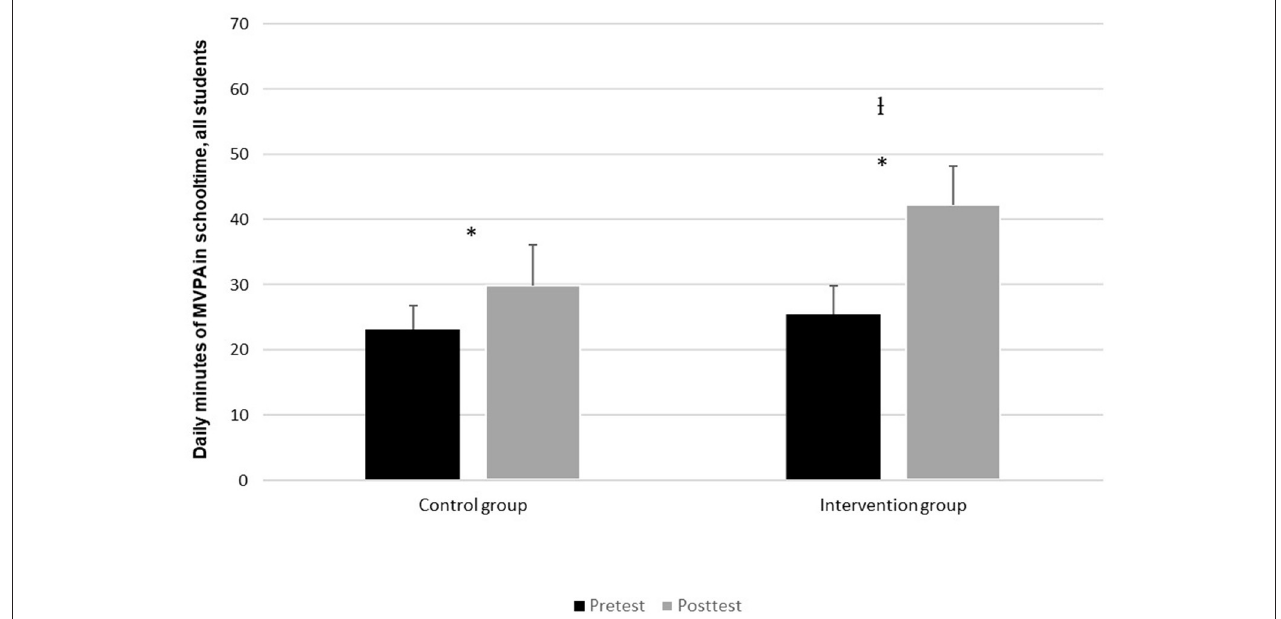
FIGURE 1 | Average daily contribution of MVPA (min) in school time at pre-test and post-test. *Indicates a significant difference ( p < 0.05) between pre-test and post-test in daily MVPA in school time. I Indicates a significant difference ( p < 0.05) in MVPA development between the control group and the intervention